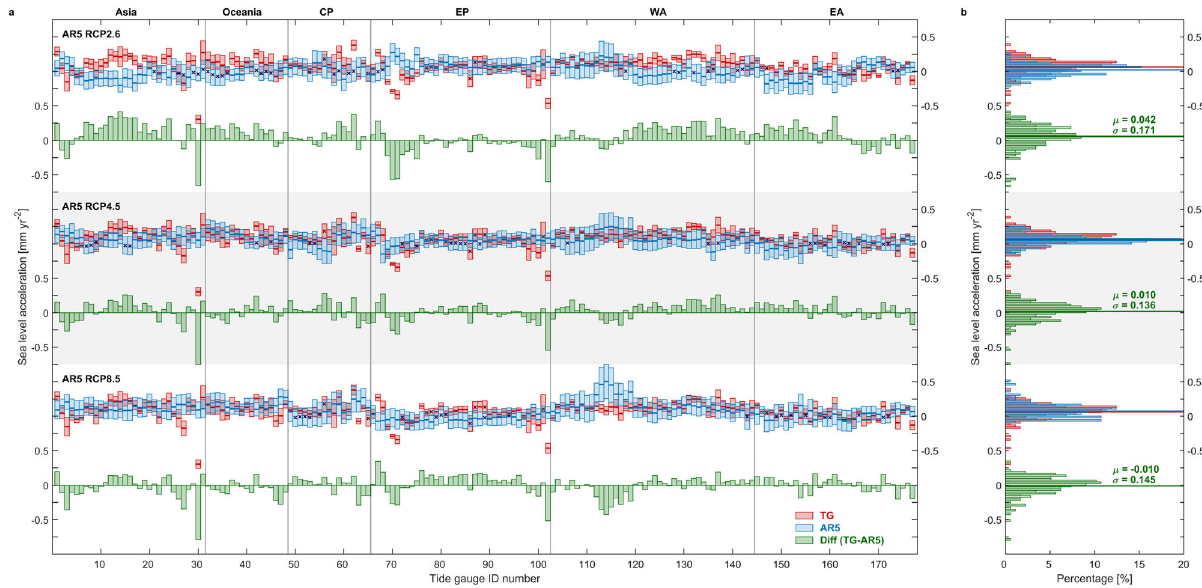
Fig. 6 Regional sea-level accelerations from tide-gauge observations (1970 – 2018) compared with the sea-level projection (2007 – 2032). Sea-level acceleration [mm yr − 2 ] are based on tide-gauge observations (TG; red), the Intergovernmental Panel on Climate Change (IPCC) Fifth Assessment Report (AR5) projection (blue) and their differences (TG minus AR5; green) at each tide-gauge station, for a box plots and b histogram, with AR5 under Representative Concentration Pathway (RCP) 2.6 (top panel), RCP4.5 (middle panel), and RCP8.5 (bottom panel) scenarios. TG accelerations with climate variability removed via multiple variable linear regression (MVLR). Error bars indicate 90% con fi dence level, and accelerations, which are not signi fi cant at 90% con fi dence level denoted as cross symbols. Region de fi nition in a is shown in Fig. 2. In histograms b , the bin width is 0.025 mm yr − 2 , horizontal lines present weighted-mean accelerations ( μ ) at all TG stations, σ denotes the standard deviation of the acceleration at all TG